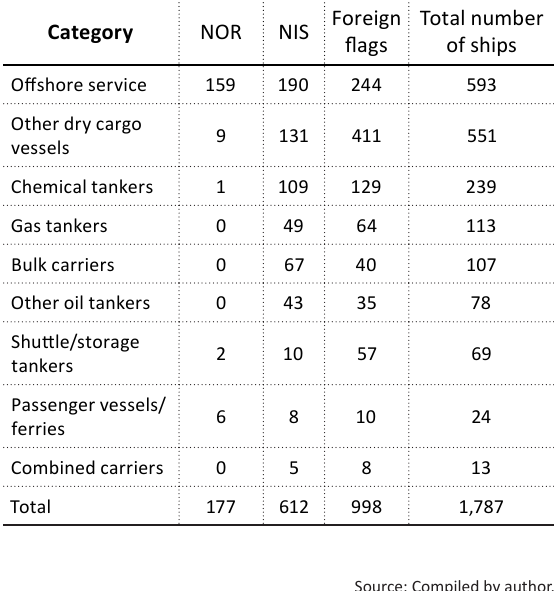
Table 1. Norwegian-controlled foreign-going fleet composition as of January 1, 2019, by number of ships Source: Norwegian Shipowners’ Association (2019).